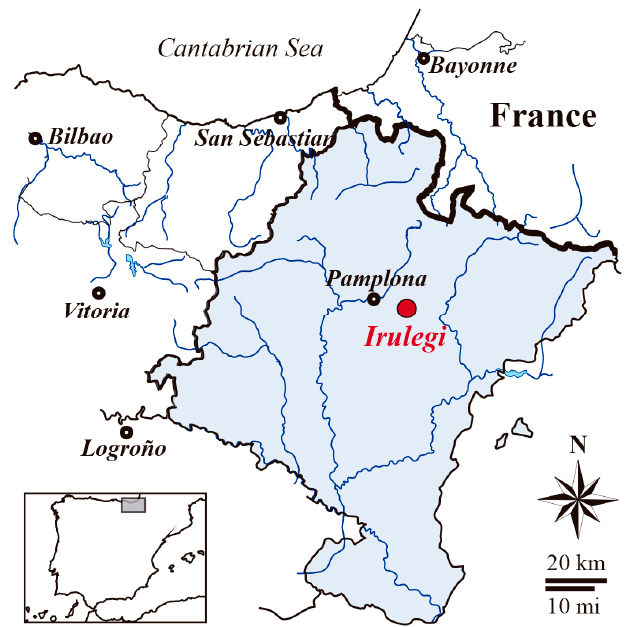
Figure 1. Geographic location of Irulegi Castle (Navarre, Spain).